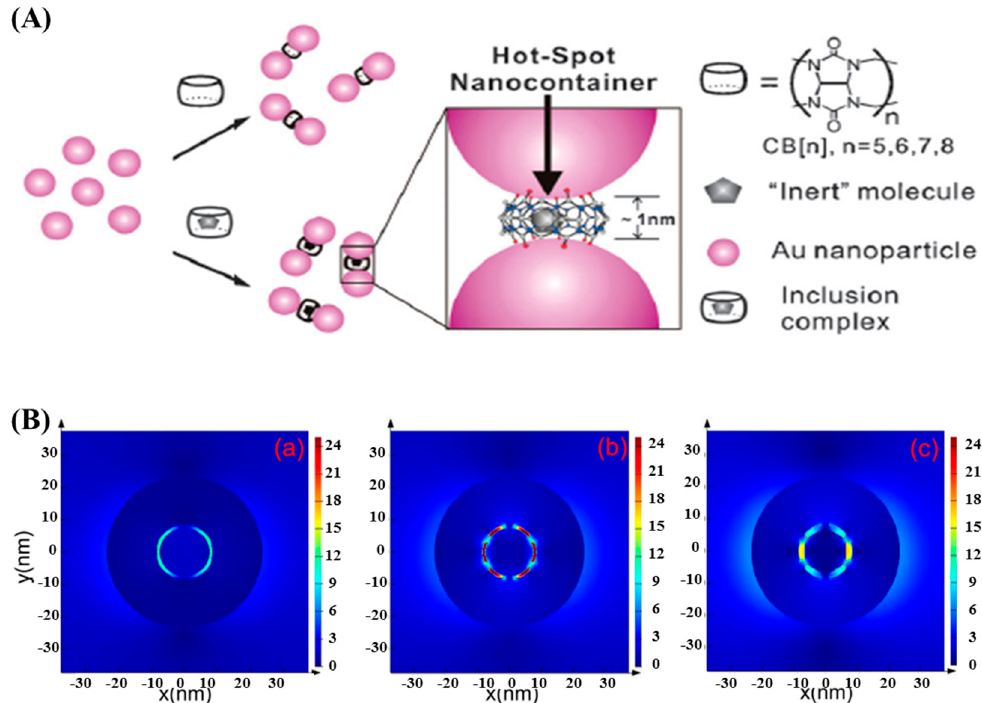
Figure 2. ( A ) Schematic illustration of the fabrication of the SERS hot spot nanocontainer system through bridging Au nanoparticles using Cucurbit (CB) [n] macrocyclic compounds. Reproduced with permission from reference [59]. ( B ) Calculated internal and near-field distributions for nanomatryoshkas (NMs) with 1-nm hollow spherical gap (left), bridged spherical gap (middle), and bridged